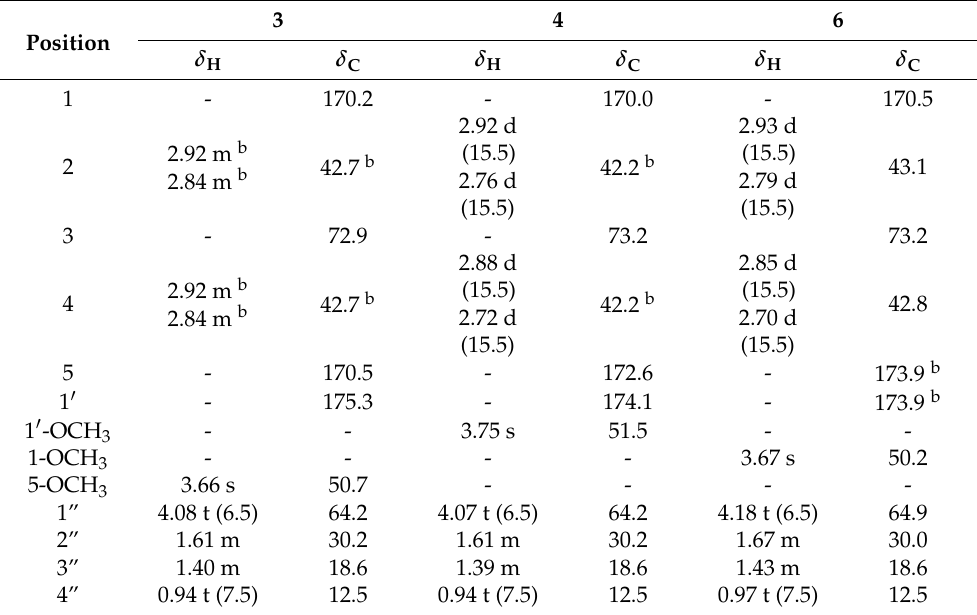
Table 1. 1 H (850 MHz) and 13 C (212.5 MHz) NMR data of compounds 3 , 4 , and 6 in CD 3 OD a .